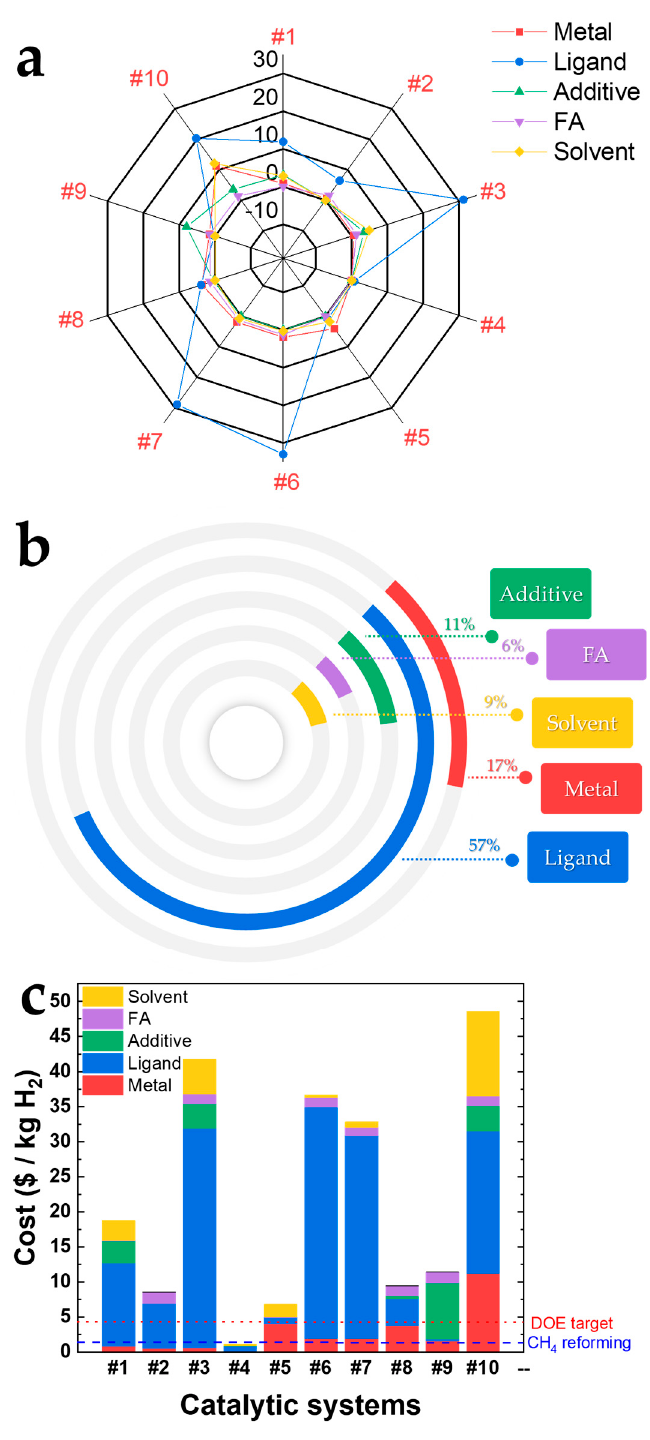
Figure 15. ( a ) Contribution of several factors (Metal, ligand, additive, FA, solvent) to the final price ($/kg H 2 ) of ten selected catalytic systems ( b ) Average percentage participation of each factor in the total system cost, ( c ) Bar graphs of ten catalytic systems. Red line: DOE target (4 $/kg H 2 ), Blue line: CH 4 reforming price (1.48 $/kg H 2 ).